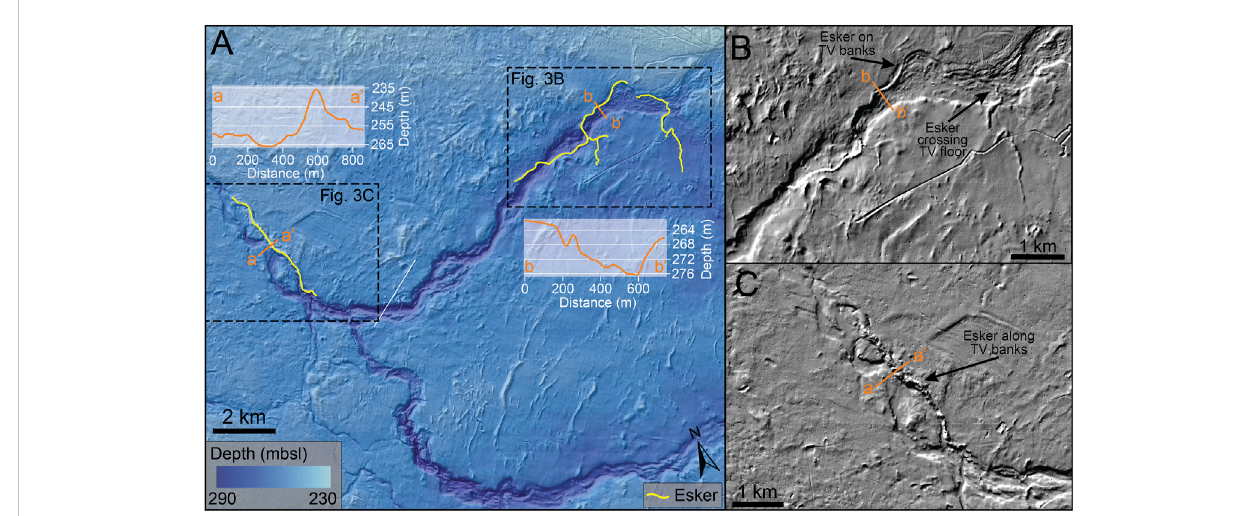
FIGURE 3 Site 1: (A) Shaded relief map with two eskers and pro fi les (a-a ’ , b-b ’ ) on the north of Thor Iversen-banken within an east-west draining tunnel valley (Newton and Huuse, 2017). (B) Hillshade map of an esker ridge crossing the tunnel valley fl oor and situated along its banks. (C) Hillshade map of an esker ridge extending parallel to the banks of the tunnel valley.